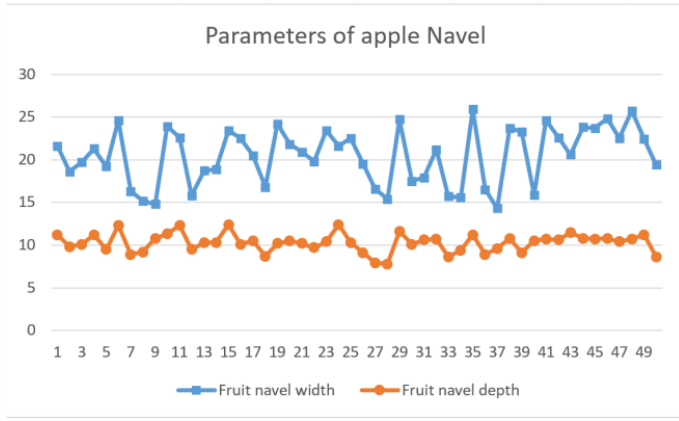
Figure 5. Apple fruit navel measurement results.